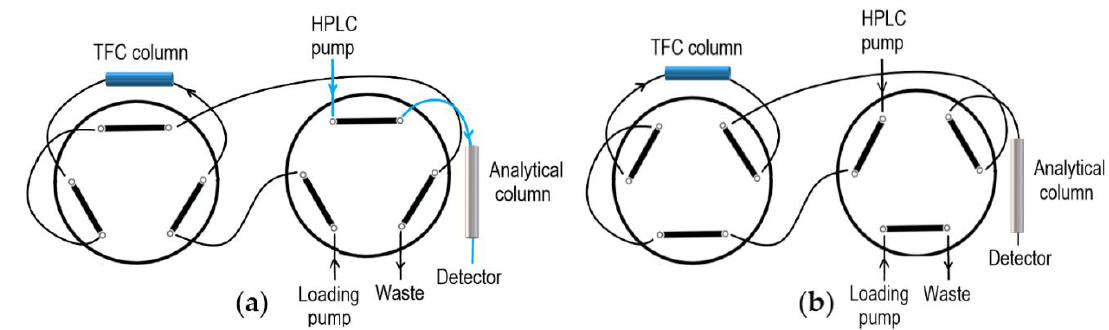
Figure 5. Schematic set up for automated turbulent-flow chromatography ( a ) loading position and ( b ) elution position. ( b ) elution